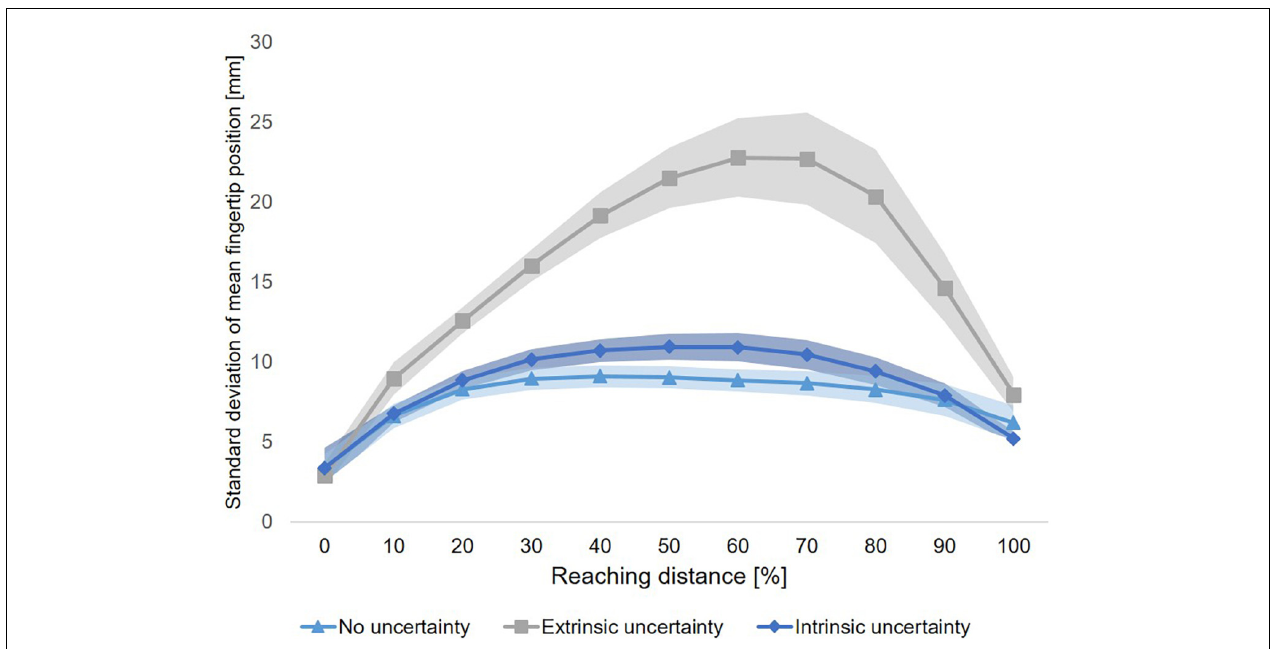
FIGURE 6 | Time course of variability of fingertip position. For each of the three experimental conditions, the time course of movement variability (mean ± SE) is displayed. Each of the three time courses show an increase-decrease pattern of movement variability, which is most strongly pronounced for Condition B (“extrinsic uncertainty”). There is no difference in variability of fingertip position at movement start between the three experimental conditions. TABLE 1 | Statistical parameters regarding the analysis of the time course of variability of fingertip position for the three experimental conditions. Time course Condition A vs. B Condition A vs. C Condition B vs.